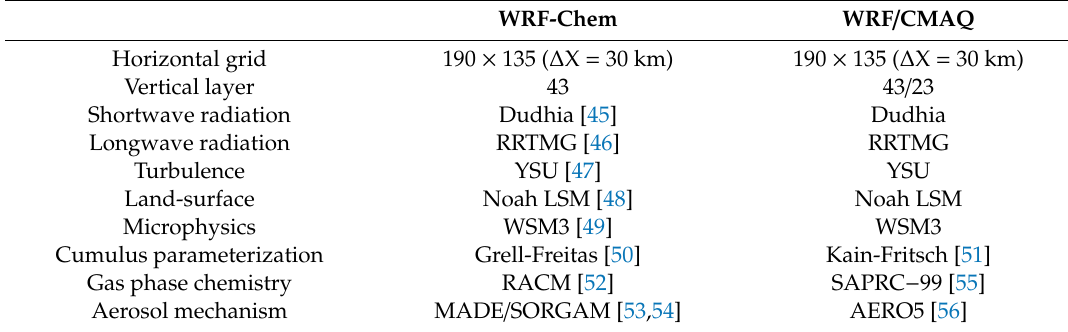
Table 1. Configuration of the Weather Research and Forecasting-Chemistry (WRF-Chem) and Weather Research and Forecasting / Community Multiscale Air Quality modeling system (WRF / CMAQ)